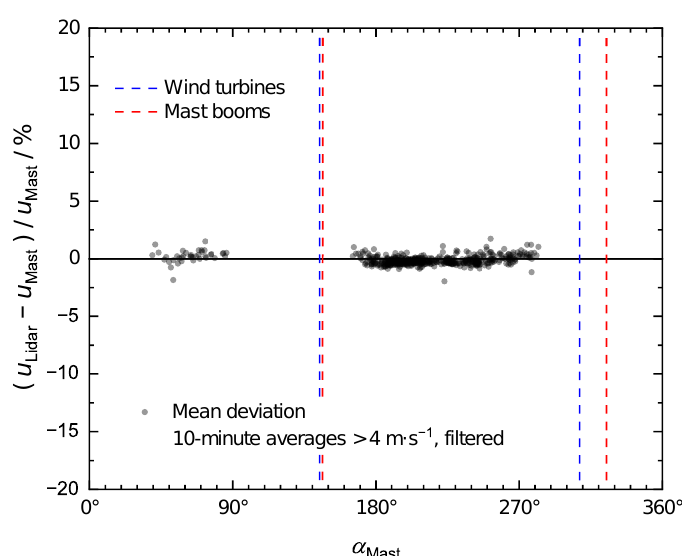
Figure 14. Results of the 2020 comparative measurement between the PTB bistatic lidar and a cup anemometer mounted on top of a 200 m met mast, showing the directional dependence of the mean deviation between the PTB bistatic lidar and the top anemometer for unfiltered 10 min averages. Large perturbation effects due to the wakes of the nearby wind turbines are visible around angles 146 ◦ and 307 ◦ . Additionally, fog occasionally causes very large, non-systematic deviations which are clearly visible between 90 ◦ and 270 ◦ angles.